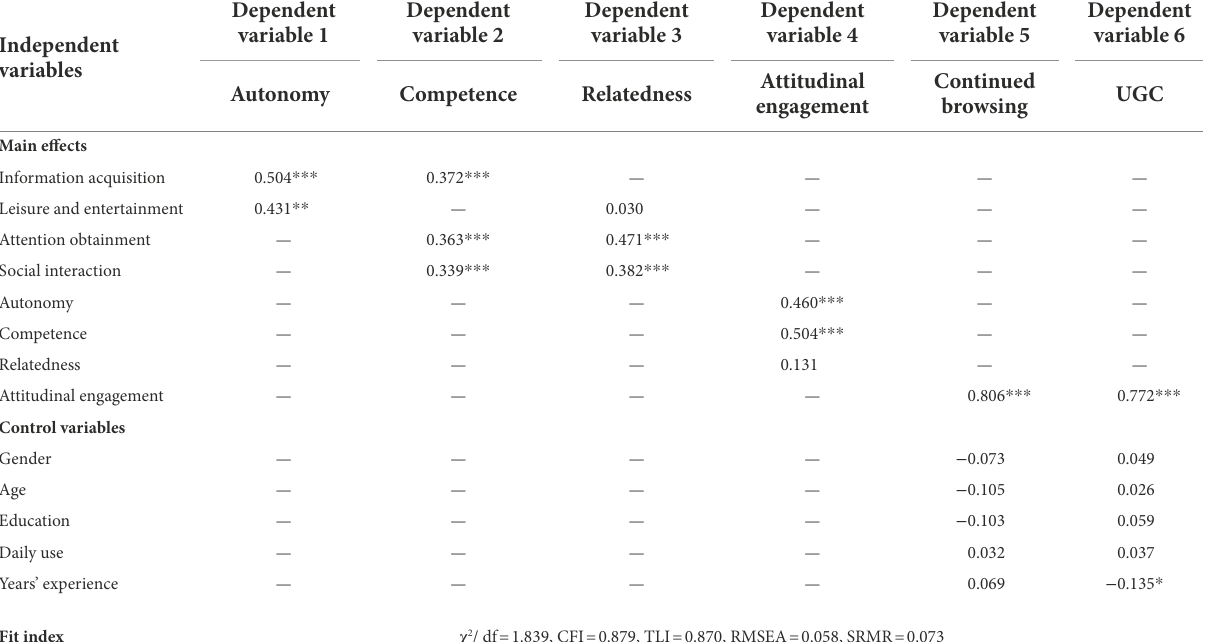
TABLE 3 Test results of the research model.